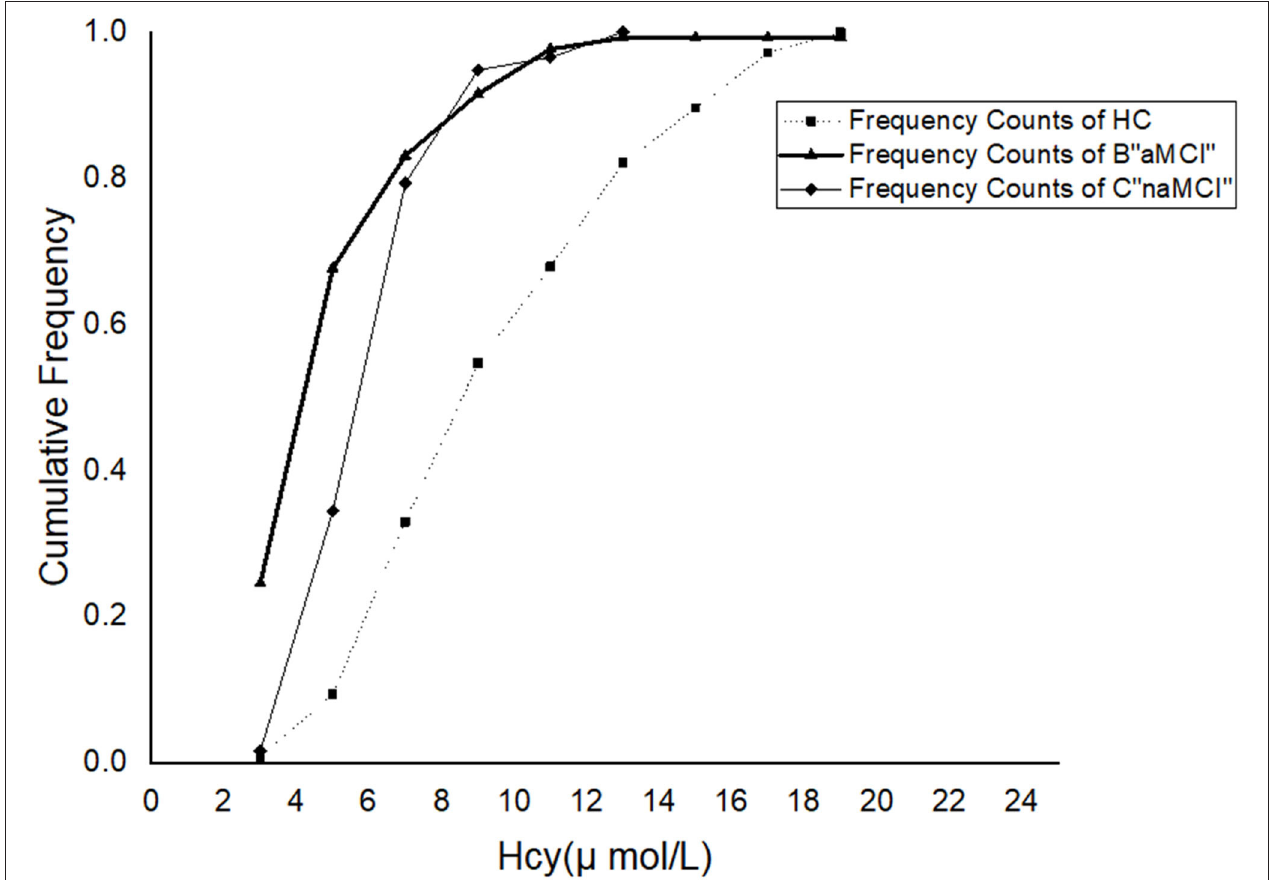
FIGURE 1 | Cumulative frequency distributions of plasma homocysteine (Hcy) levels in the healthy controls and aMCI and aMCI subjects.